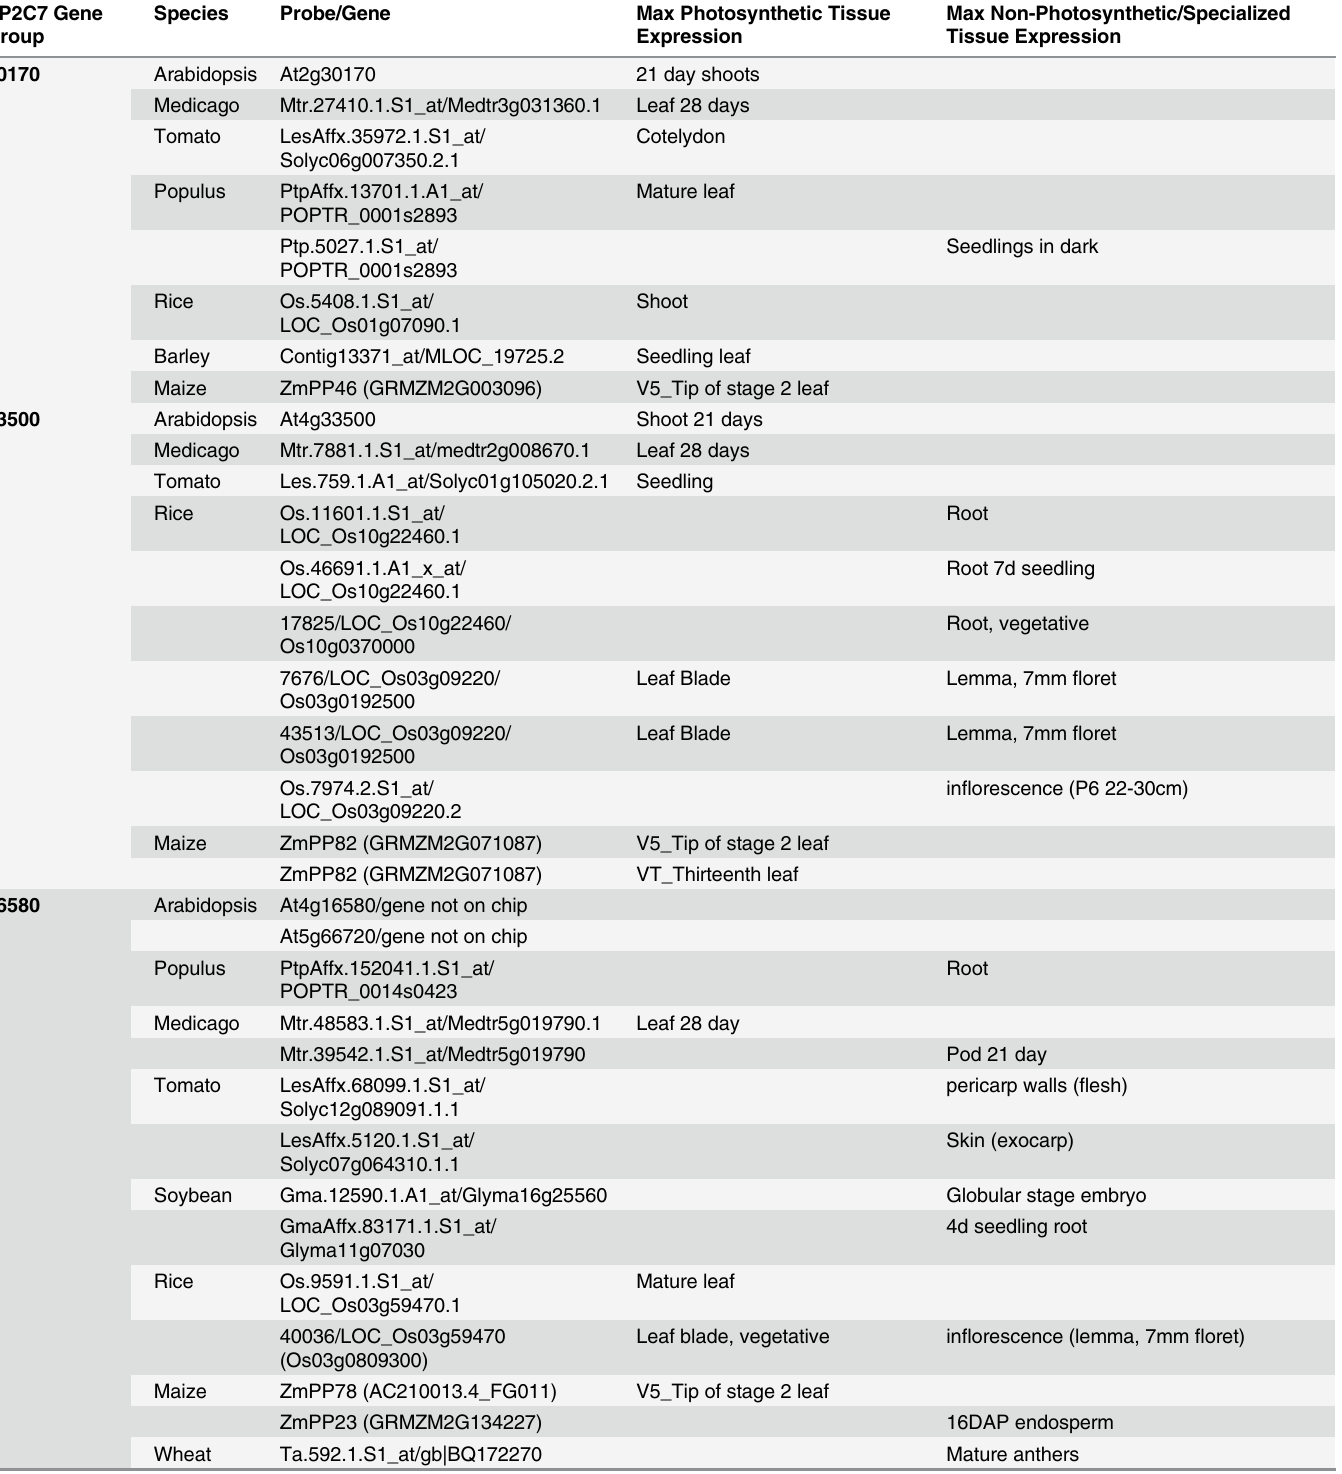
Table 1. Summary of plant PP2C7 gene expression